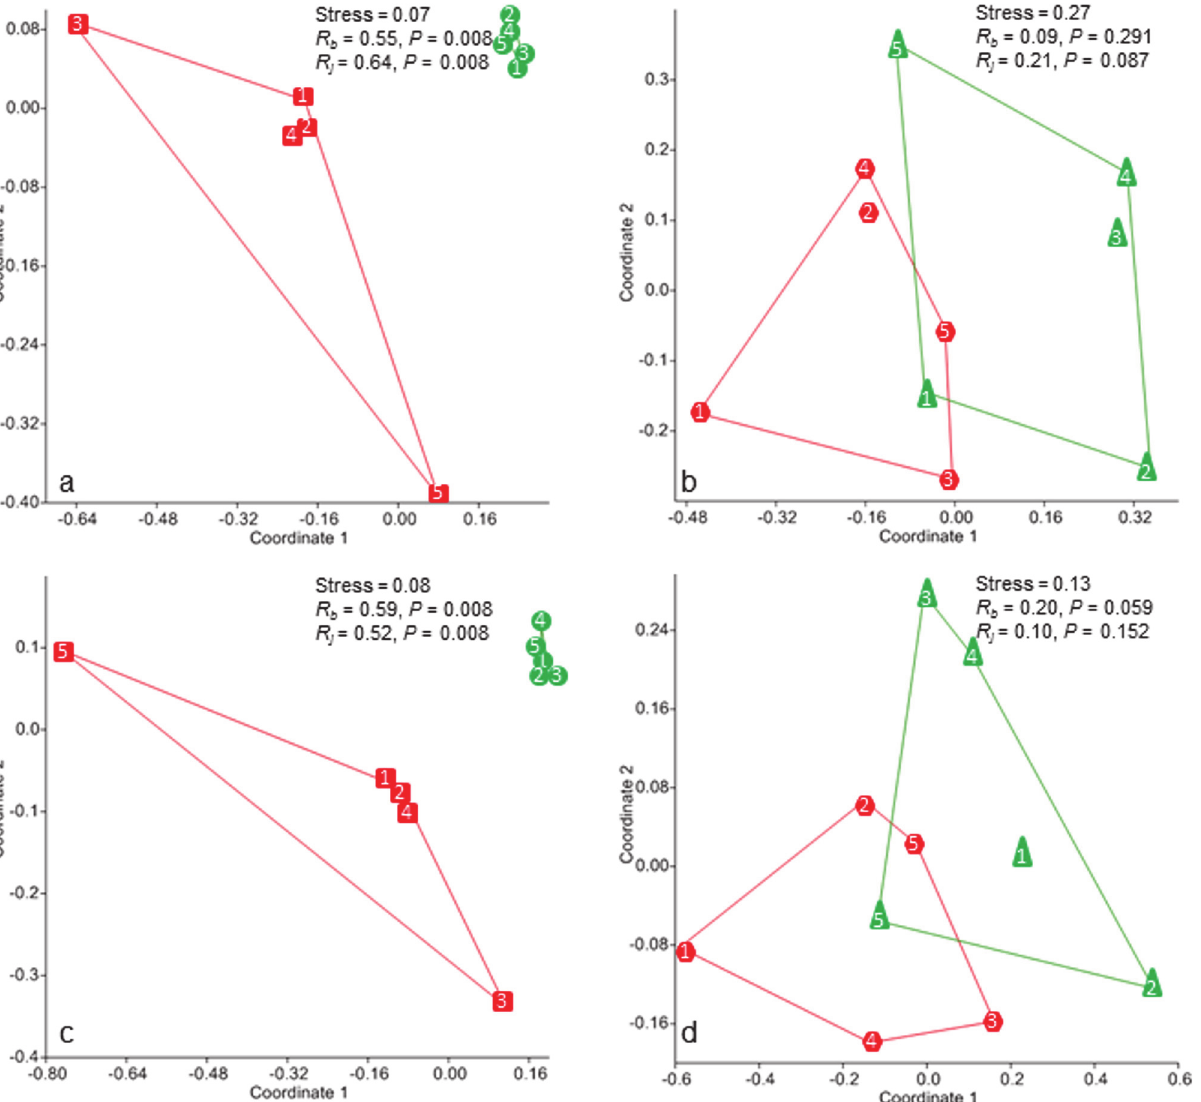
Fig 2. NMDS ordination plots of bacterial community structure in soil (a, c) and wood (b, d) samples using different primer sets: 1406f/23Sr (a, b) and ITSF/ITSReub (c, d). Stress values from the NMDS ordinations and R ANOSIM based on Bray-Curtis ( R b ) and Jaccard ( R j ) distance measures are shown on the right. Square = fertilized soil, circle = unfertilized soil, hexagon = Picea abies , triangle = Fagus sylvatica . Each number (1 to 5) represents one individual replicate.